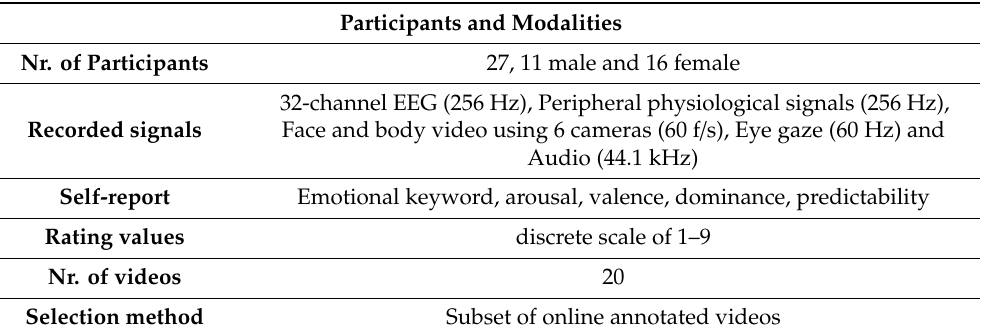
Table 2. Summary of MAHNOB-HCI